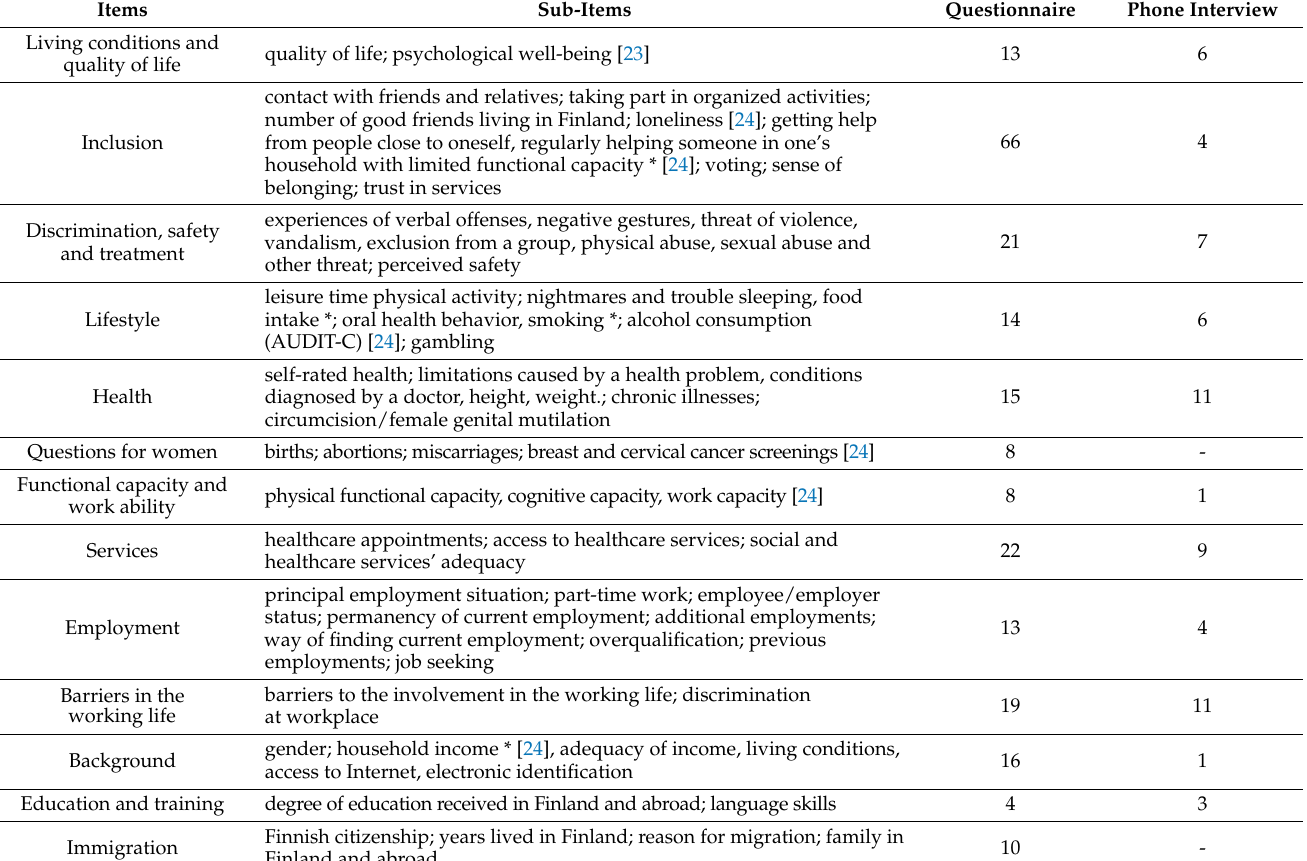
Table 1. Overview of the survey measures and the number of questions used in questionnaire and phone